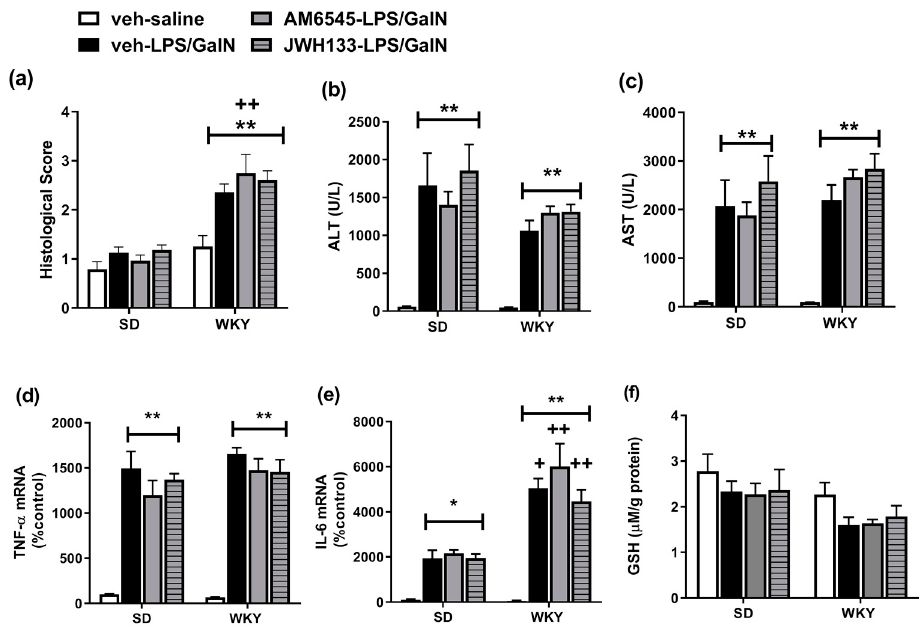
Figure 5. Effect of AM6545 and JWH133 on ( a ) histopathological score, ( b ) ALT ( c ) AST, ( d ) TNF- α , ( e ) IL-6 mRNA and ( f ) hepatic GSH levels in SD and WKY rats. Data expressed as mean ± SEM ( n = 6–8). * p < 0.05 ** p < 0.01 vs. vehicle–saline counterpart + p < 0.05 ++ p < 0.01 vs. SD counterpart.